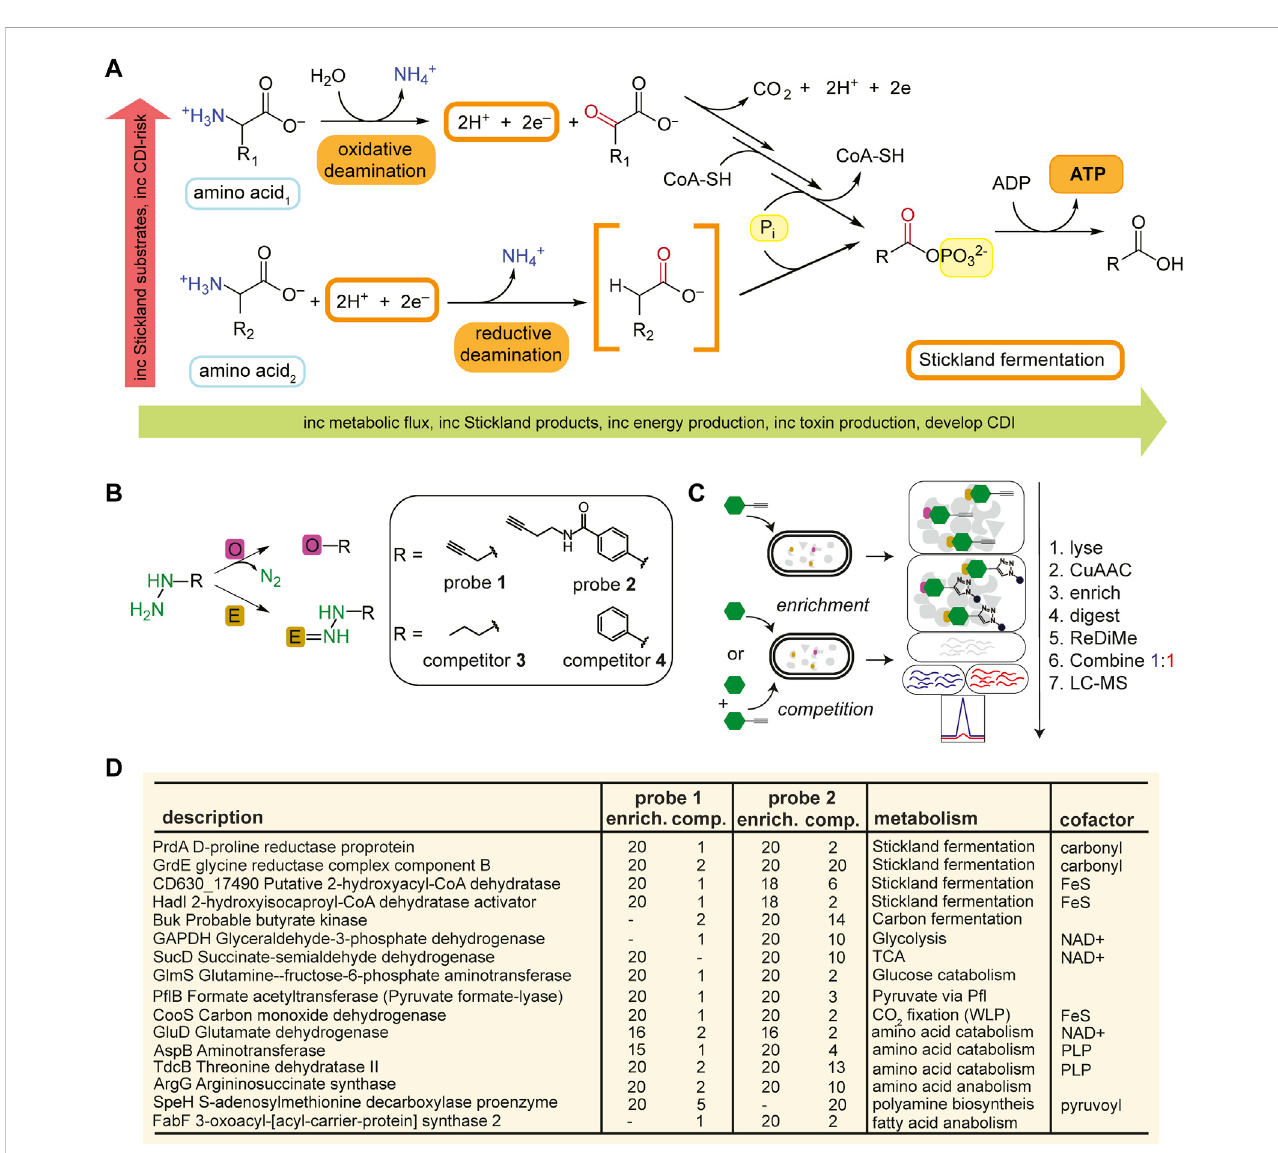
FIGURE 1 Identi fi cation of metabolic protein targets by hydrazine probes in C. dif fi cile . (A) , Representative schematic of Stickland fermentation coupled oxidation andreductionofaminoacidstogenerateATP. (B) ,Labellingmechanismsofelectrophilic(E)andoxidative(O)cofactorsbyhydrazine.Hydrazinewarheadsare shown in green. R is structure of probe or competitor. See Supplementary Figure S3 for full structures. (C) , Schematic for MS 2 -based quantitative proteomics experiments (enrichment and competition) in living bacteria using late-stage reductive dimethylation. Isotopically heavy and light peptides are depicted in blue and red, respectively. (D) , High-reactivity protein targets of hydrazine probes in C. dif fi cile associated with metabolic pathways shown in Supplementary Figure S1. See Supplementary Figure S6; Supplementary Datasets S1, S2 for complete protein target